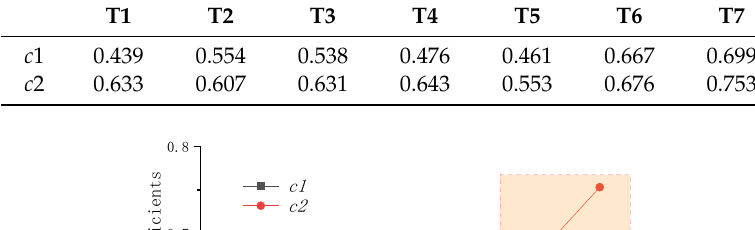
Table 3. Insulator structure coefficients.